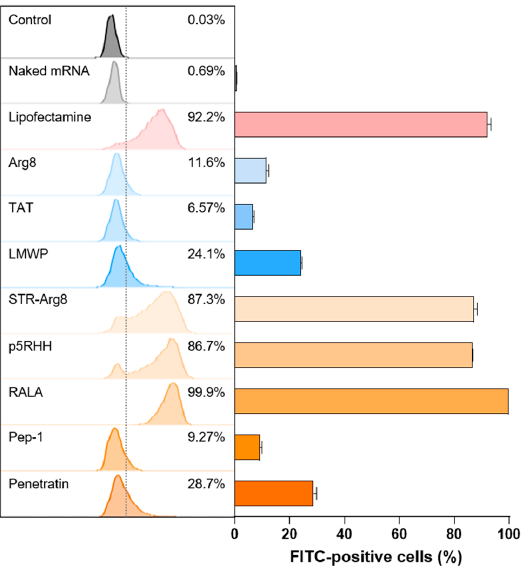
Figure 5. Cellular uptake of CPP/mRNA complexes. Representative flow cytometry histograms and quantified graph of FITC-positive CL26.CL25 cells transfected with CPP/Fluorescein-labeled mCherry mRNA complexes (6.8 nM). Data are presented as the mean ± SD ( n = 3). In contrast, comparable or higher mRNA uptake efficiencies to Lipofectamine were observed for STR-Arg8 (83.7%), p5RHH (86.7%) and RALA (99.9%)-mediated mRNA